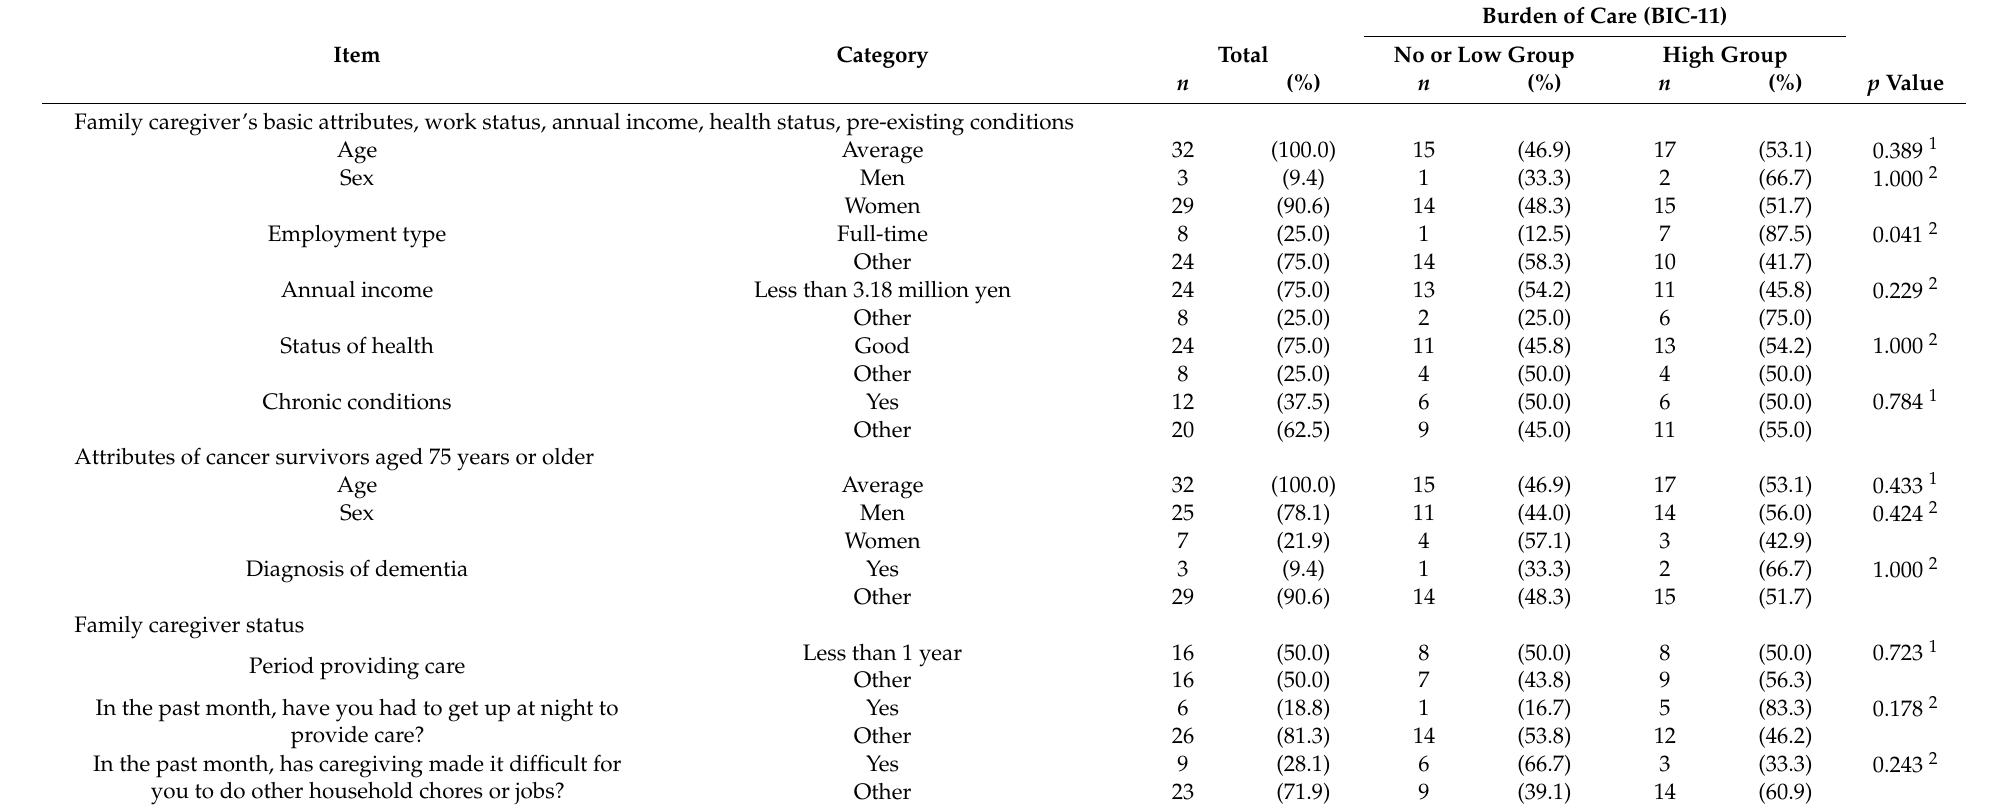
Table 2. Background and caregiving status of family caregivers and cancer survivors in relation to BIC-11 (n =